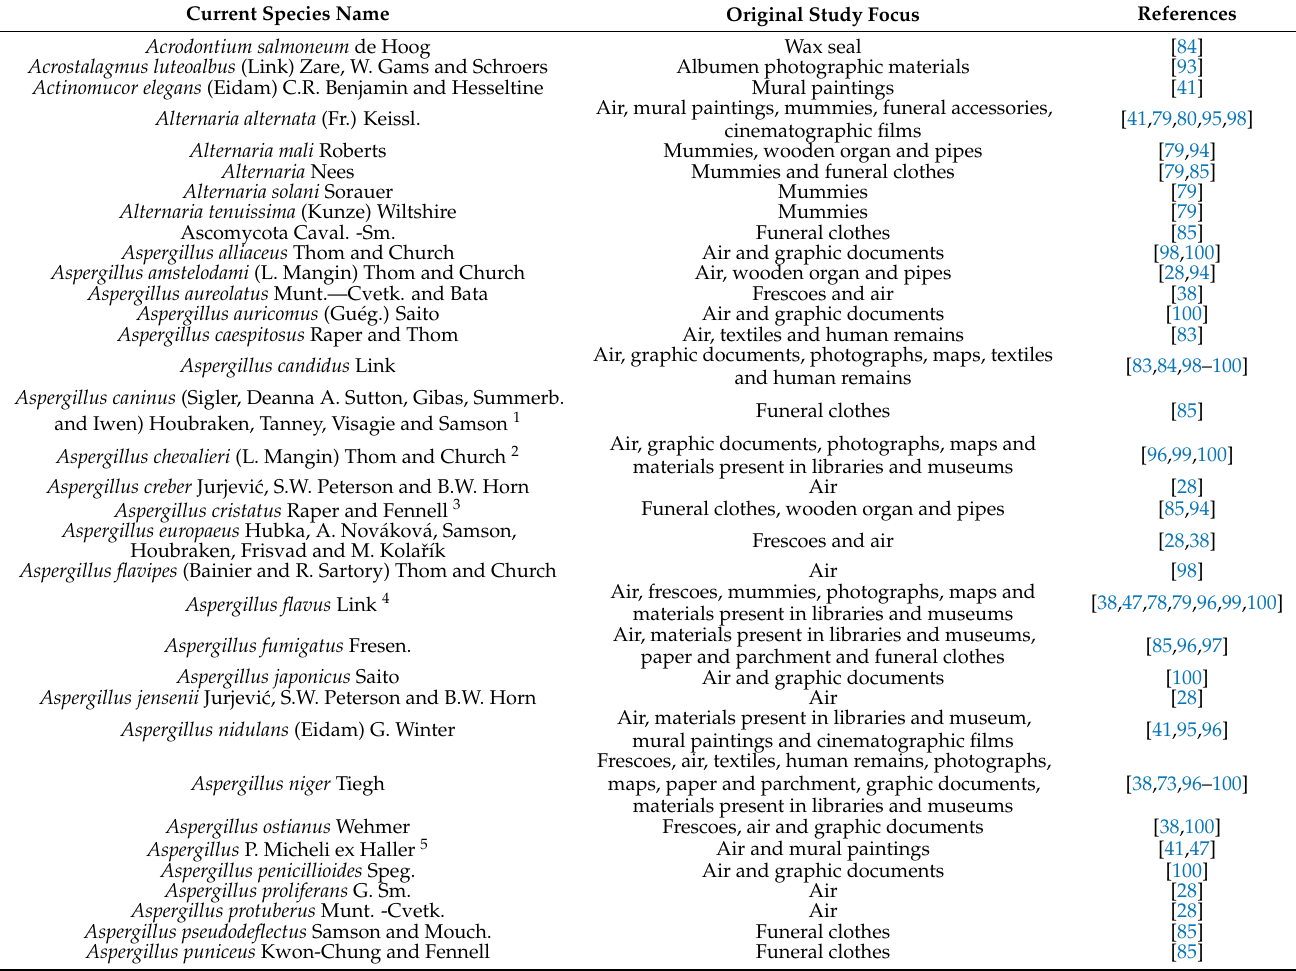
Table 8. Overview of fungal species for which isolates have been identified as displaying proteolytic abilities in biodeterio- rative plate